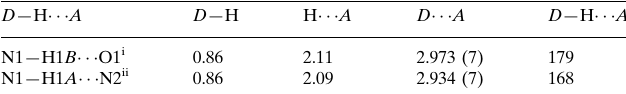
Data collection Rigaku Saturn 724 CCD area- detector diffractometer